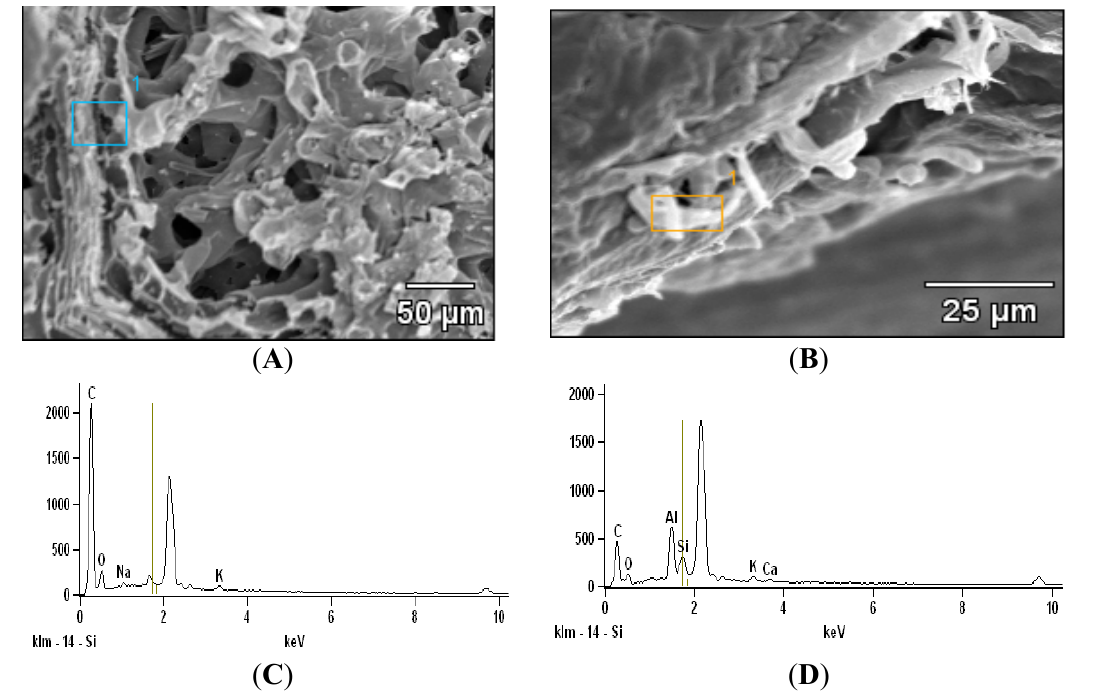
Figure 3. Scanning electron microscopy images of ( A ) − Si and ( B ) + Si mature leaves, white granules are areas of silicon detection. The selected areas (blue and orange blocks) were examined for elemental composition by energy dispersive X-ray analysis (EDAX) ( C ) − Si leaves ( D ) + Si leaves.